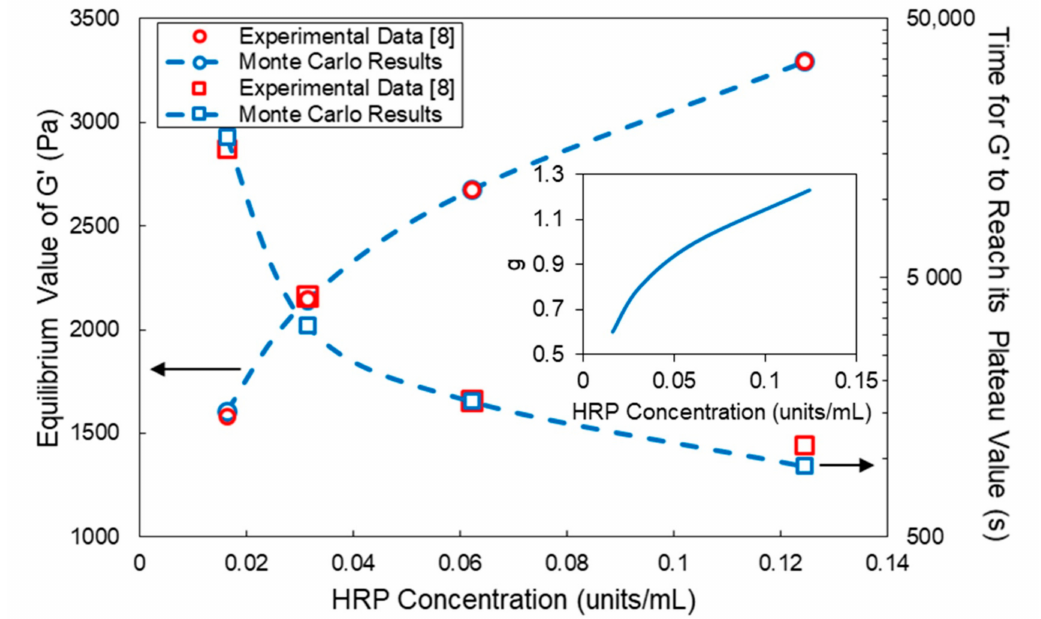
Figure 9. Effect of the HRP concentration on the G (cid:48) equilibrium value and time required for G (cid:48) to reach its plateau value for the HA-Tyr crosslinkable solution (i.e., 1.75% w/v , MW = 90 kDa and H 2 O 2 concentration = 728 µ M). Blue squares with a blue dashed line and blue circles with a blue dashed line represent the MC calculated values, and red circles and squares denote the respective experimental measurements of Lee et al. [8]. All MC simulations were conducted with an initial polymer chain population of ~10 6 .